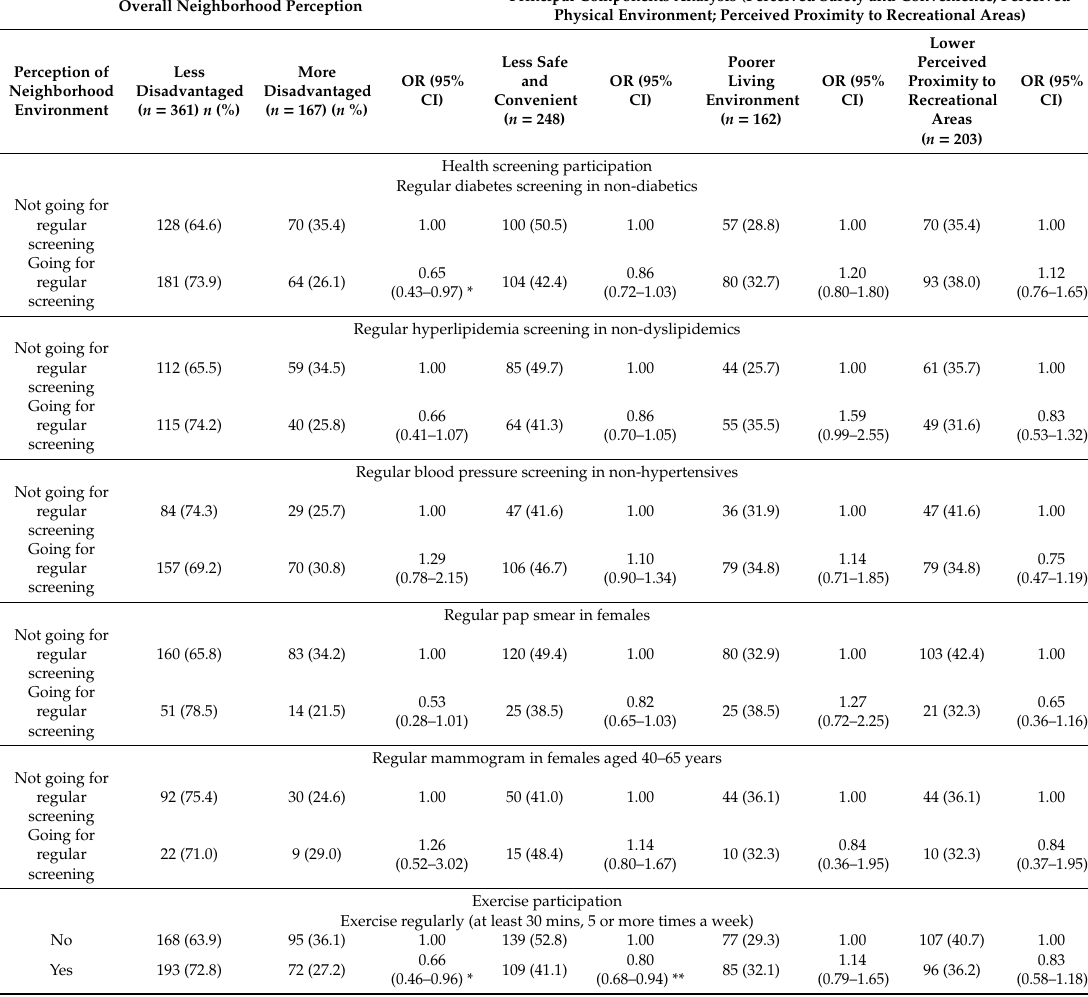
Table 4. Associations between perception of neighborhood environment and regular screening participation and exercise, amongst residents in two public housing precincts in Singapore, on univariate analysis ( n = 528).